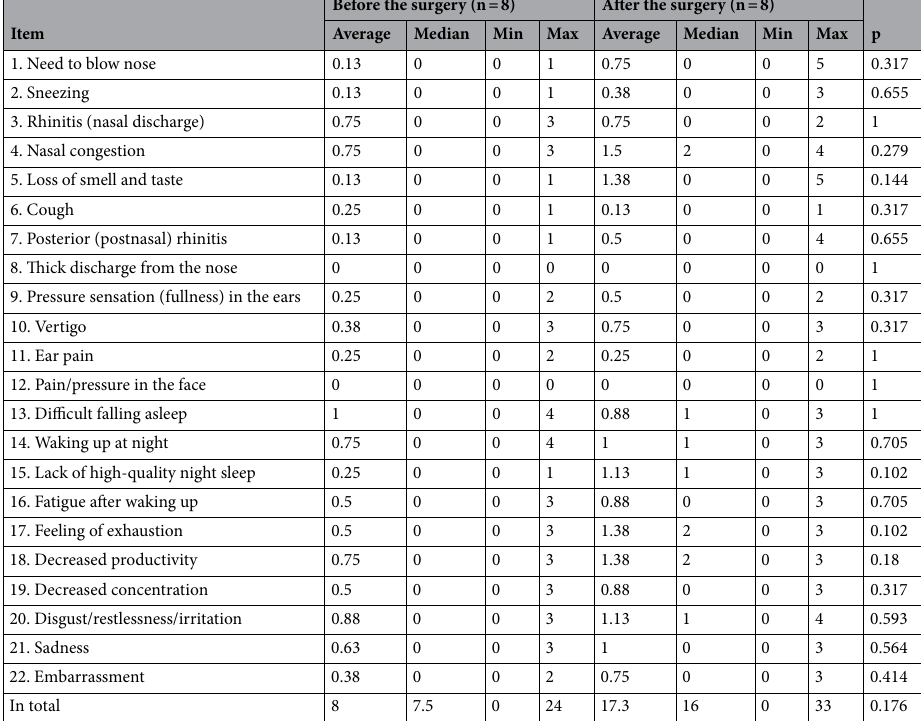
Table 4. SNOT-22 scores before the surgery and six months after the surgery in a subgroup of patients without cranial base